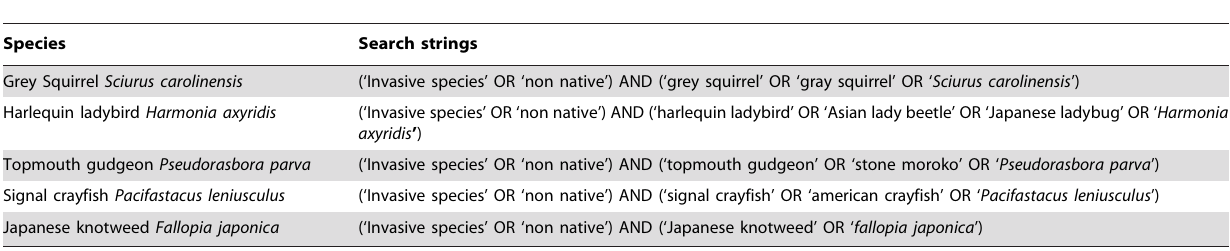
Table 1. Search strings allocated to non-native species.